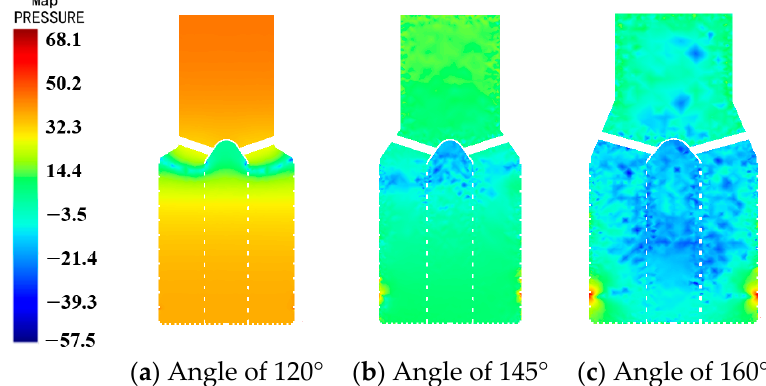
Figure 18. Sound pressure level distribution of different schemes at the second peak.